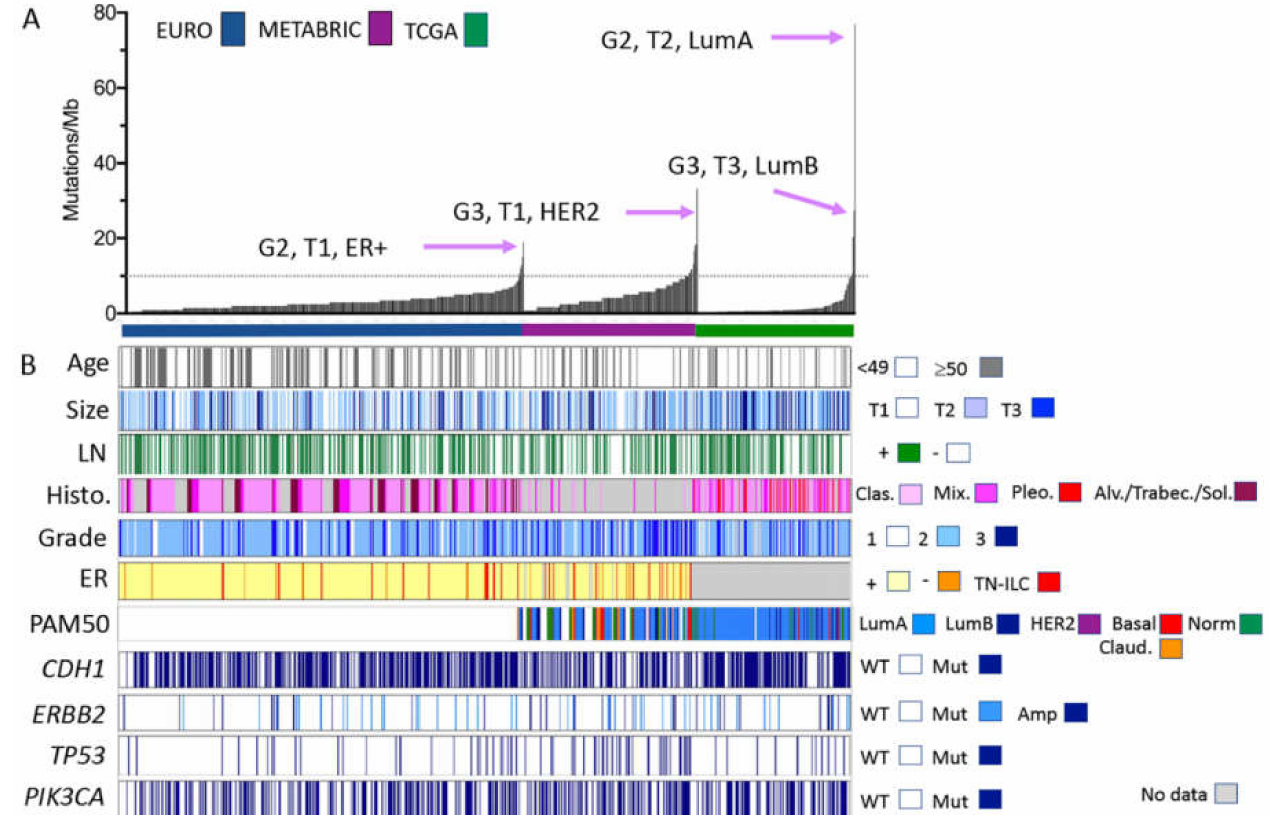
Figure 1. Clinical, morphological, and molecular characteristics of ILC cohorts analysed by gene panel and exome sequencing. ( A ) Individual ILC from three separate cohorts are ordered along the x -axis by increasing the mutation burden ( y -axis, calculated according to the number of mutations detected per Mb of the genome sequenced). Tumour features (grade, size, and tumour phenotype) of those ILC with the highest mutation burden in each cohort are highlighted. ( B ) Clinical and pathological features of the tumours sequenced and mutations detected in common driver genes in ILC. Size: <2 cm = T1; 2–5 cm = T2; >5 cm = T3. Abbreviations: Alv = alveolar; Amp = amplified; Clas. = classic; ER = oestrogen receptor status; LN = lymph node; Mix. = mixed and other variants; Mut = mutated; TN-ILC = triple negative ILC; Sol. = solid; Trabec = trabecular; WT = wild type; G2 = grade 2; G3 = grade 3; LumA/LumB = Luminal A/B phenotype; and Claud. = claudin-low.